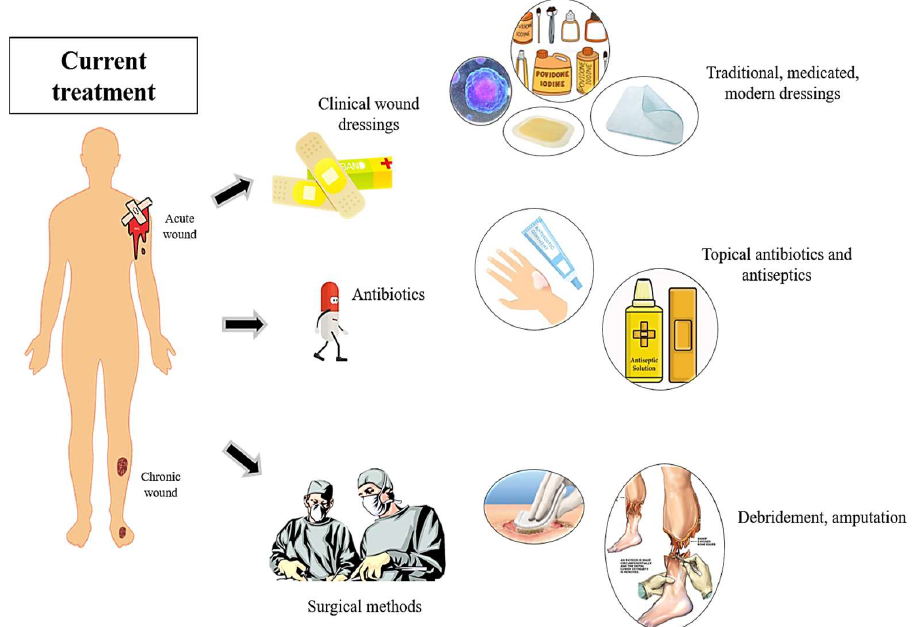
Figure 2. Current available treatments for wound healing for acute and chronic wounds. The methods include traditional and modern approaches as well as the treatment technique.